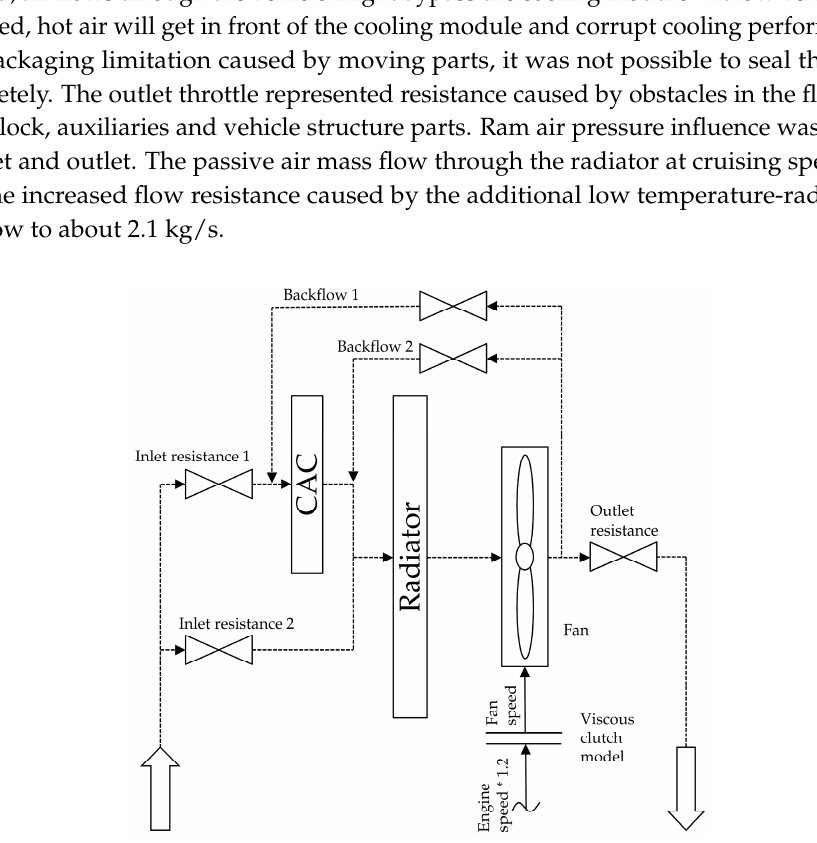
Figure 9. Air path modelling approach.